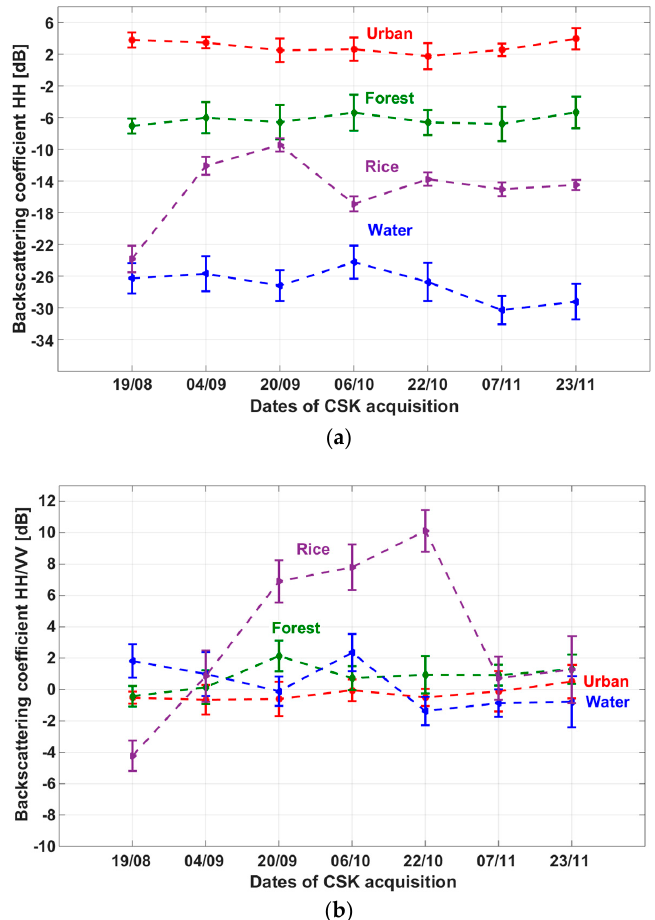
Figure 9. Temporal variation and standard deviation of ( a ) HH backscattering coefficient and ( b ) polarization ratio HH/VV of the four LULC sampled classes: forest in green, urban in red, river (water) in blue and rice in violet, extracted from CSK images of seven dates.